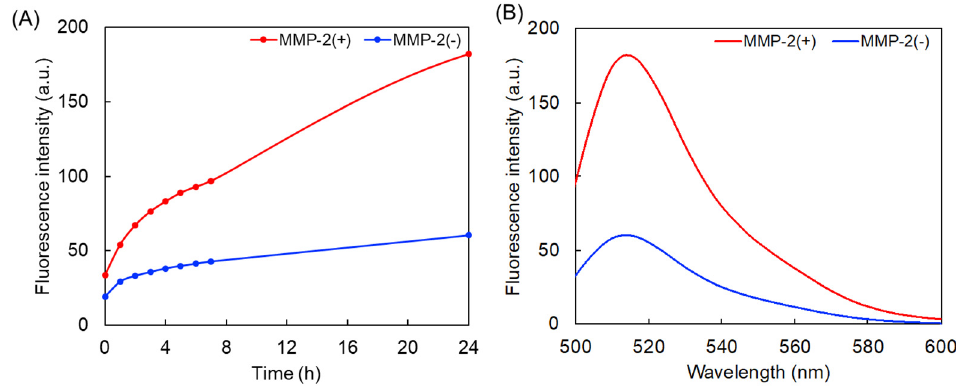
Figure 3. MMP − 2-responsiveness of the dendrimer. ( A ) Time-dependent fluorescence intensity of the dendrimer (1 µ M) at 514 nm in the absence and presence of MMP − 2. ( B ) Fluorescence spectra after 24 h in the absence and presence of MMP − 2.